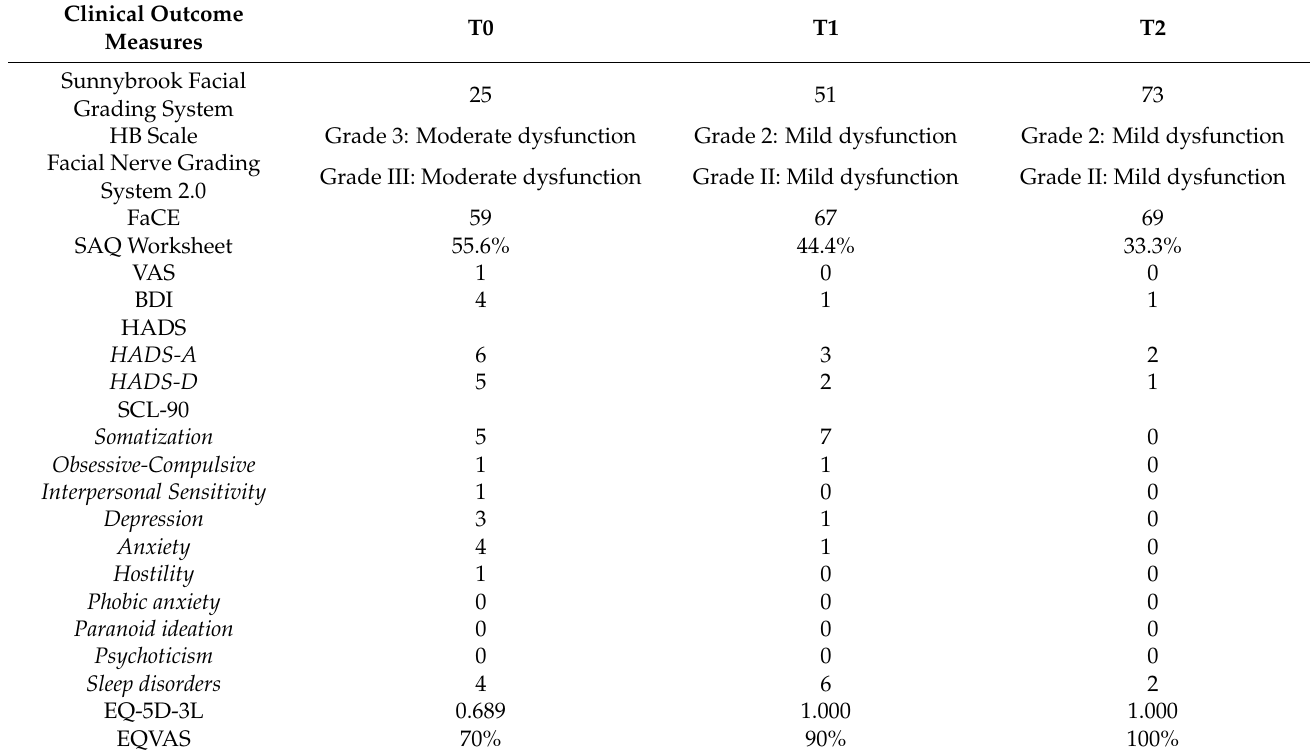
Table 1. Clinical outcome